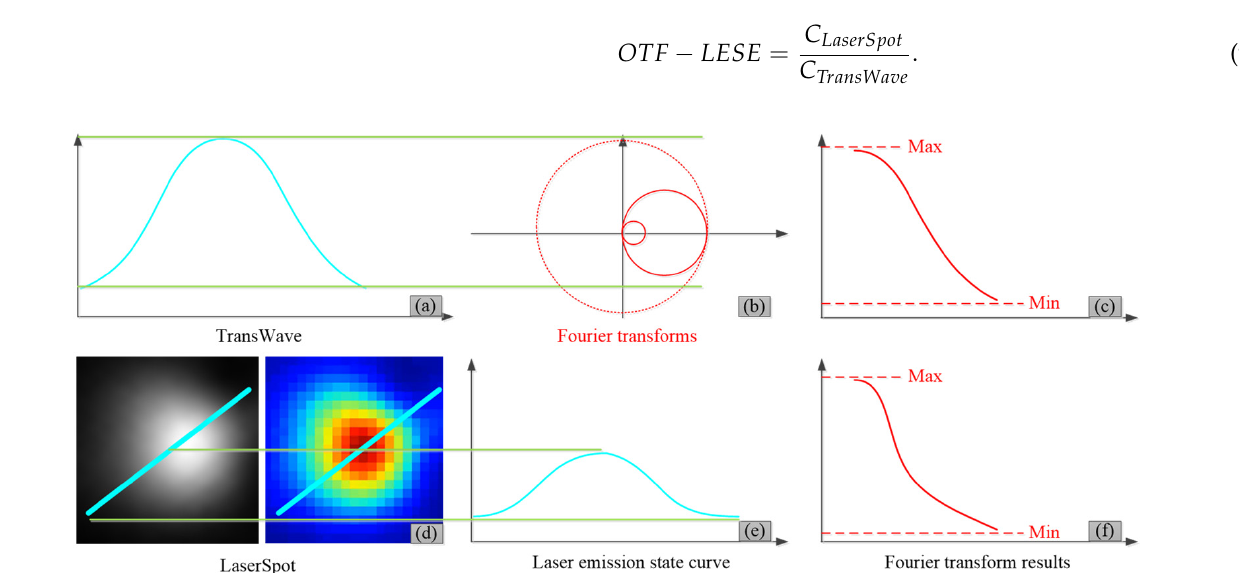
Figure 4. Calculation flow of the optical transfer function for laser emissions state evaluation. ( a ) Transmitted waveform of laser. ( b ) Fourier transform process. ( d ) Laser spot and its rendered image. ( e ) Laser emission state curve. ( c , f ) respectively correspond to Fourier change results of emission waveform and laser emission state curve.